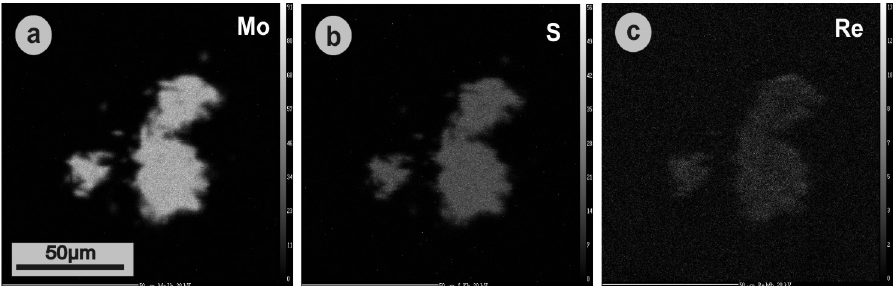
Figure 7. Back-scattered electron images showing the distribution of Mo, S and Re in molybdenite grains from Pagoni